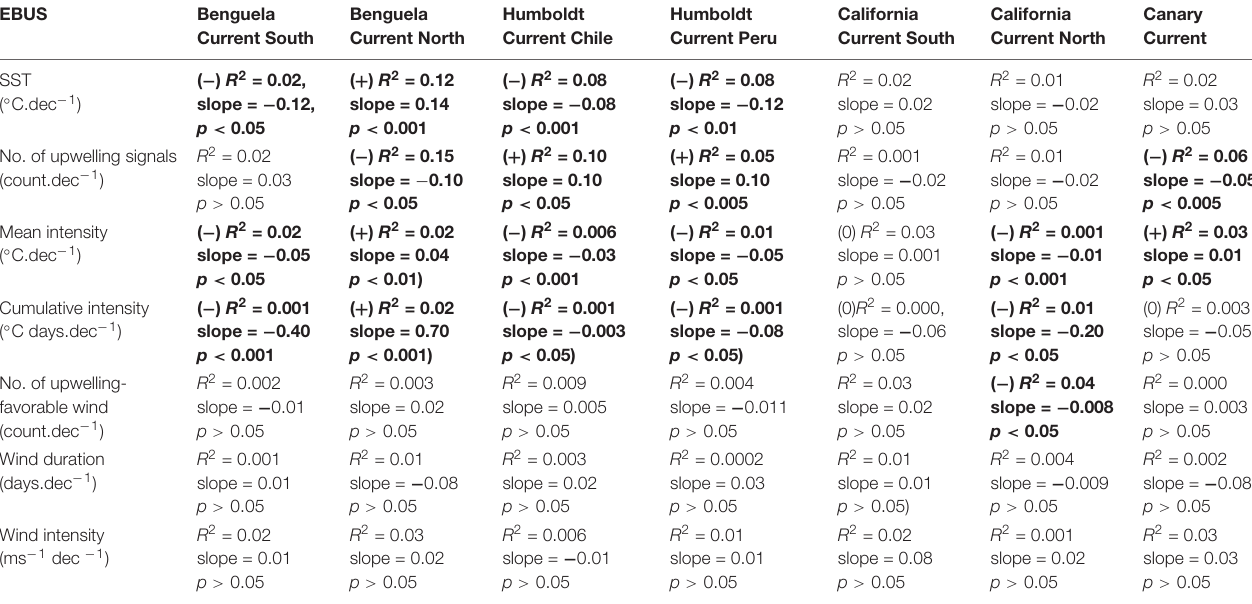
TABLE 2 | Results from linear regressions in upwelling favourable winds and upwelling metrics over a period of 37 years.